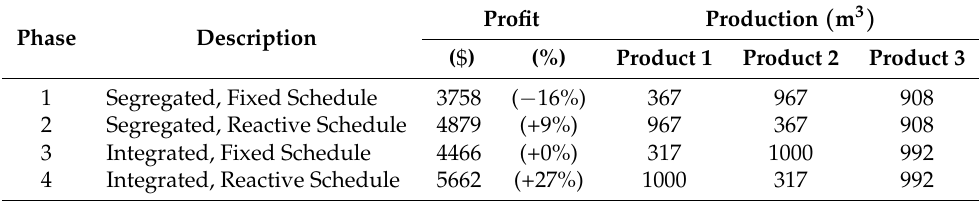
Table 9. Results: Scenario